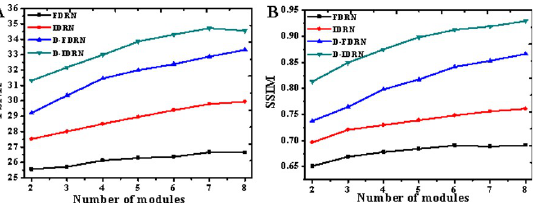
Fig 3. Quality analysis on reconstructed images under different models. Note: Fig 3A and 3B illustrated the comparisons of PSNR and SSIM of the reconstructed image under different models,